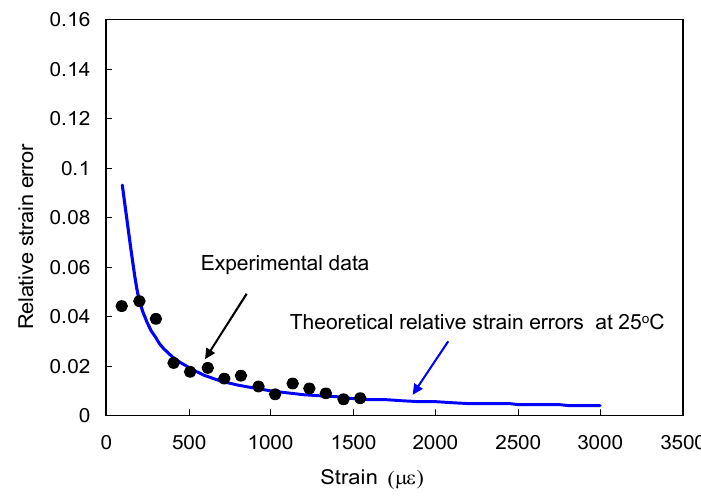
Figure 6. Measured and calculated relative strain error as a function of strain. In error analysis, the measurement errors in wavelength were neglected.